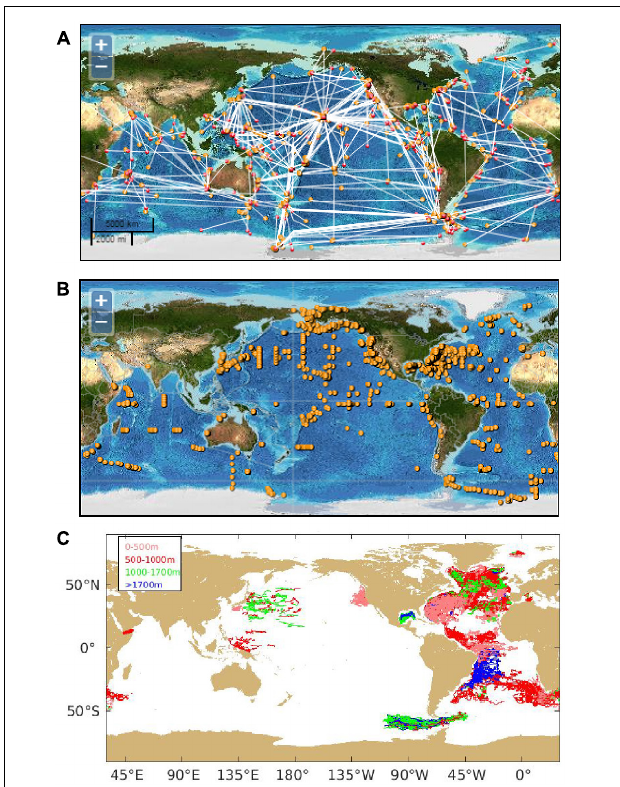
FIGURE 2 | Data available from two recently created archives (see text). From the NOAA National Centers for Environmental Information (NCEI) Global Ocean Currents Database (GOCD), two screen shots show (A) shipboard ADCP data (which includes data from the Joint Archive for Shipboard Acoustic Doppler Current Profiler Data, JASADCP; and the Rolling Deck to Repository, (R2R, funded by the National Science Foundation and the Office of Naval Research), and (B) mooring data. (C) Trajectories of RAFOS floats from the WOCE Subsurface Float Data Assembly Center, updated through December 2017. Colors indicate depth (legend in upper